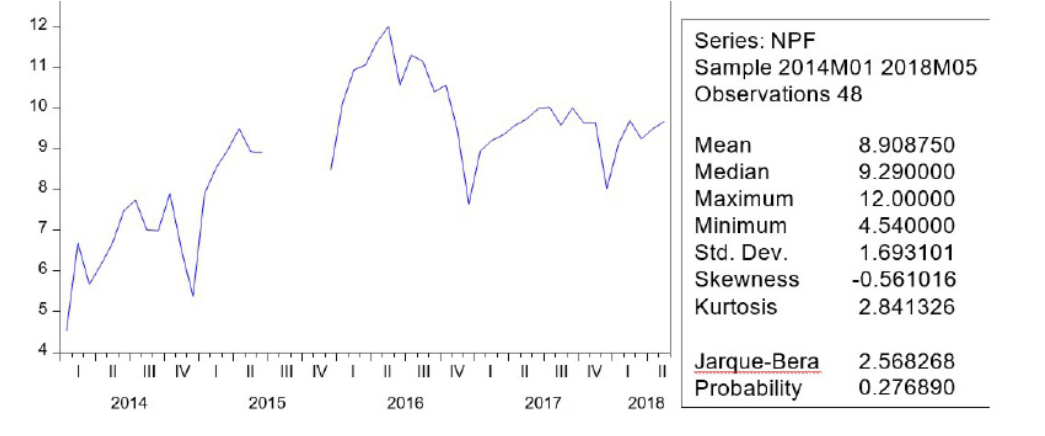
Figure 3: Growth in the Number of BPRS Non Performing Financing (NPF) in East Java Province Source: Data Processed